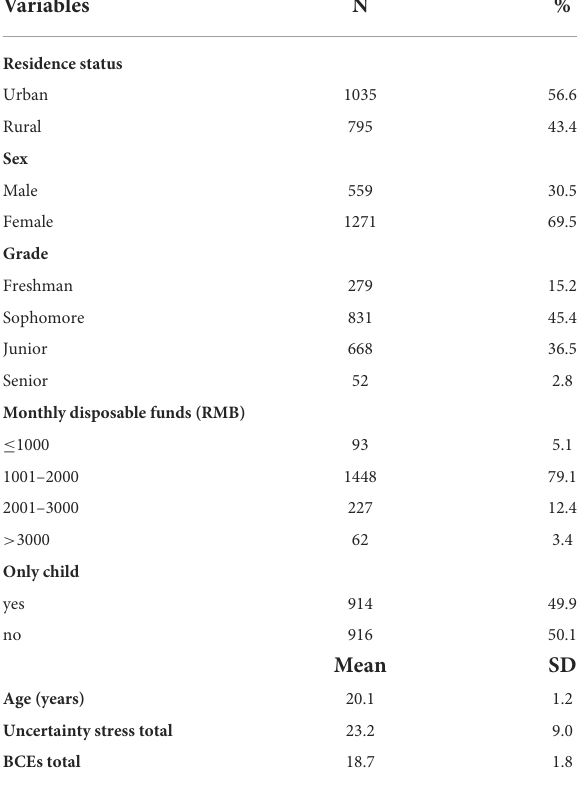
TABLE 1 Demographic characteristics of the study sample ( n =